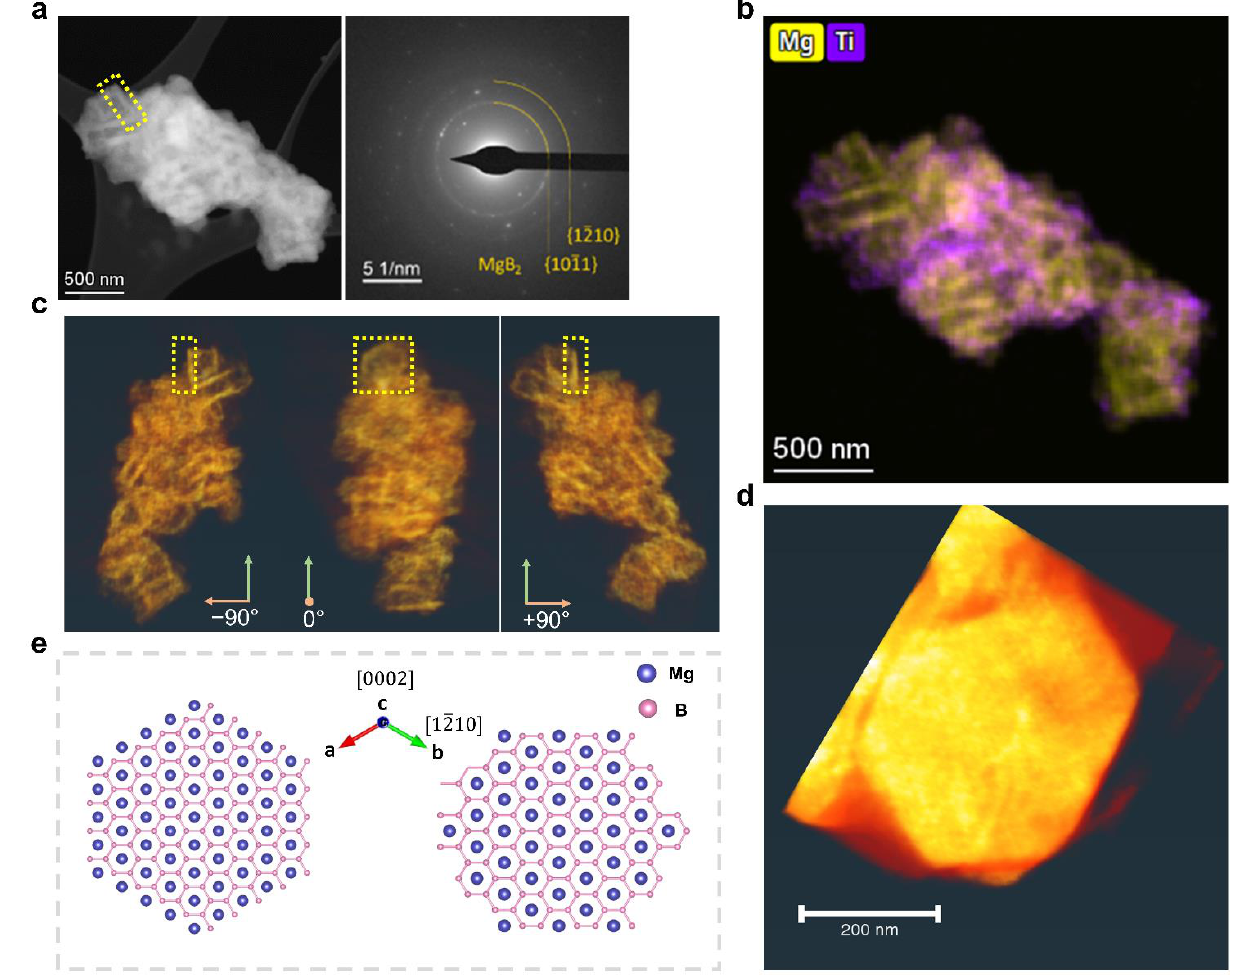
Figure 3. Desorbed 2LiBH 4 –MgH 2 with 10 mol% 3TiCl 3 · AlCl 3 : ( a ) STEM-HAADF image and the corresponding DP; ( b ) Summed EDX elemental map of Mg (K lines) and Ti (K lines) acquired in the same position as image a; ( c ) Tomography images based on the dataset of EDX map of Mg (K lines) acquired in the same region as image a visualized at the angle − 90 ◦ , 0 ◦ and +90 ◦ . The MgB 2 platelet highlighted in the yellow box is exactly the one highlighted in image ( a ); ( d ) 3D visualization from tomographic reconstruction of the selected MgB 2 crystal indicated in images ( a , c ) shows a hexagonal platelet; ( e ) Schematic illustration of the crystallographic orientations for a MgB 2 hexagonal platelet in the zone axis